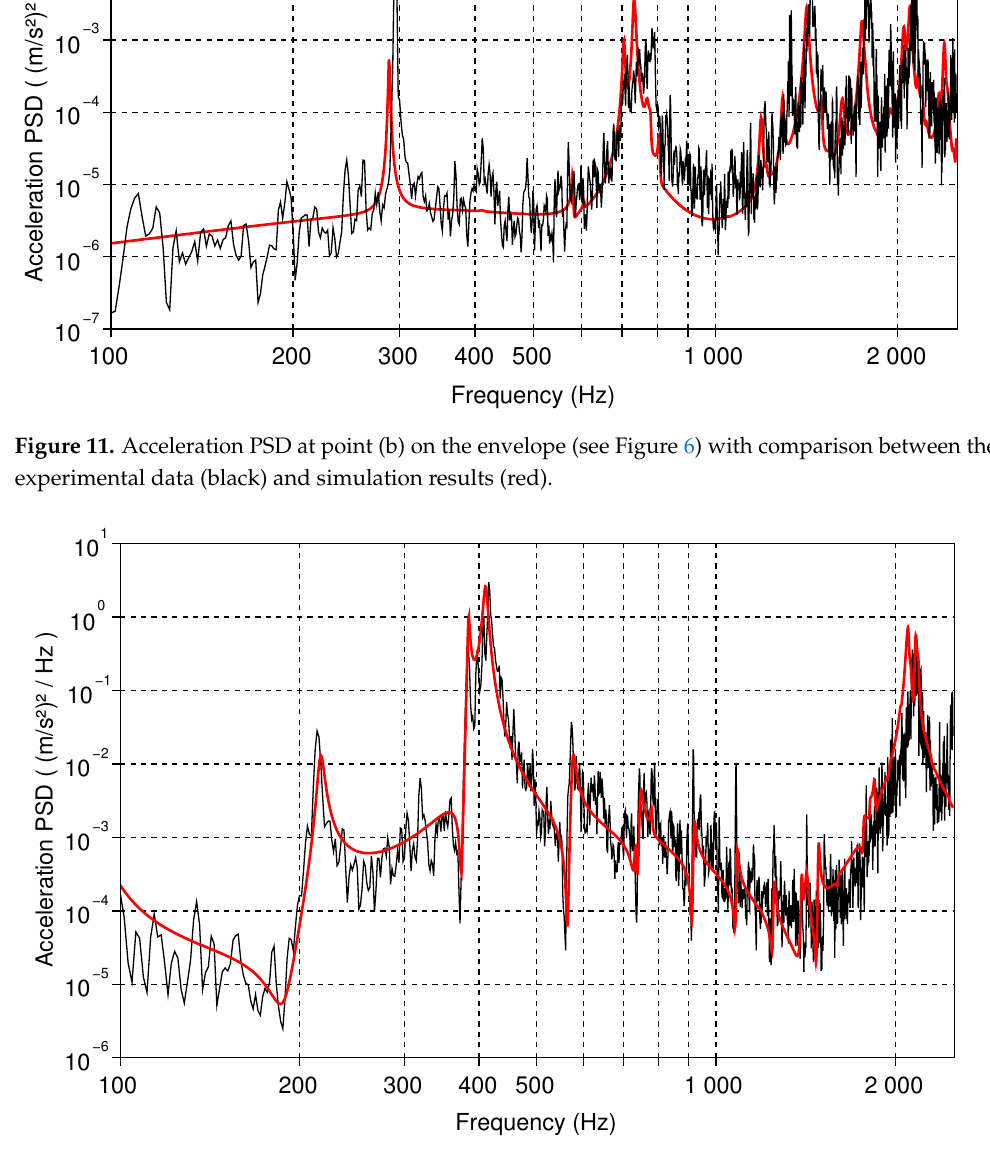
Figure 12. Acceleration PSD at at point (c) on the bottom (see Figure 6) with comparison between the experimental data (black) and simulation results